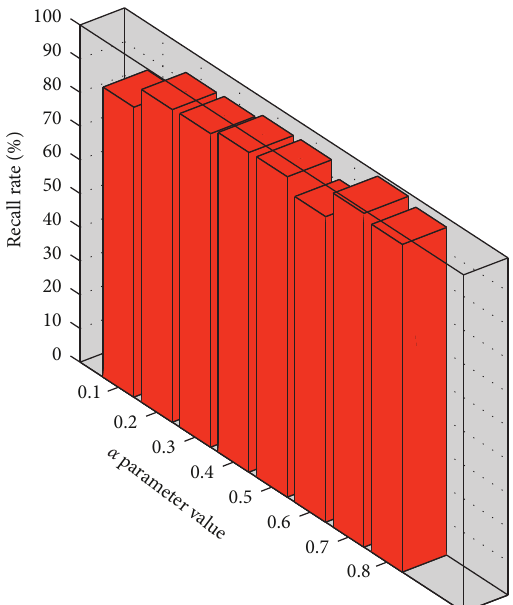
Figure 9: The change of recommended recall rate after case-based reasoning under different α parameters.